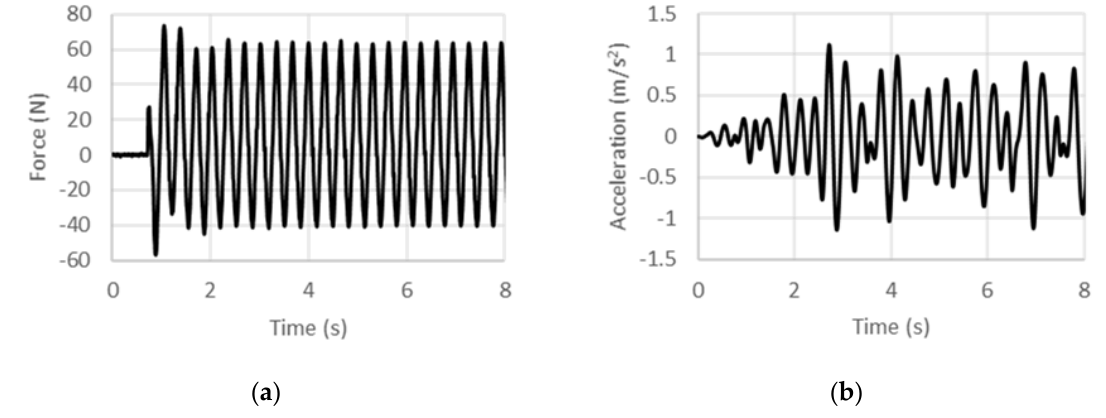
Figure 9. Experimental ( a ) force and ( b ) acceleration histories at 3 Hz under displacement control.